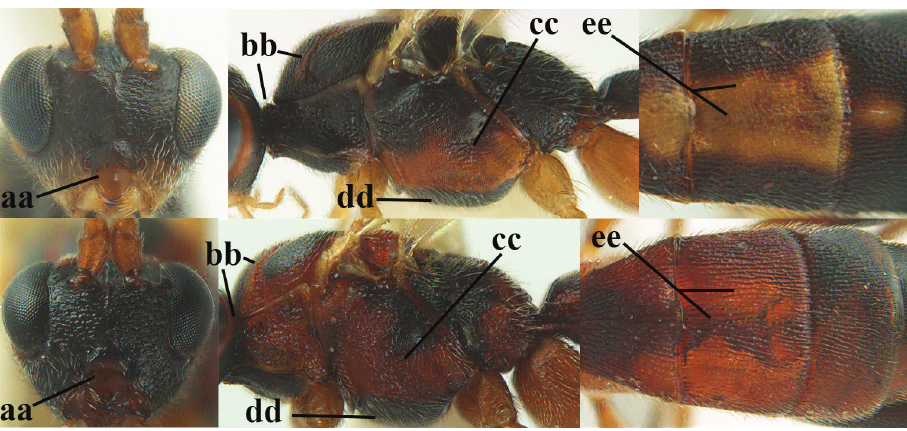
median carina (ee); lateral margins of third and fourth tergites of ♂ almost